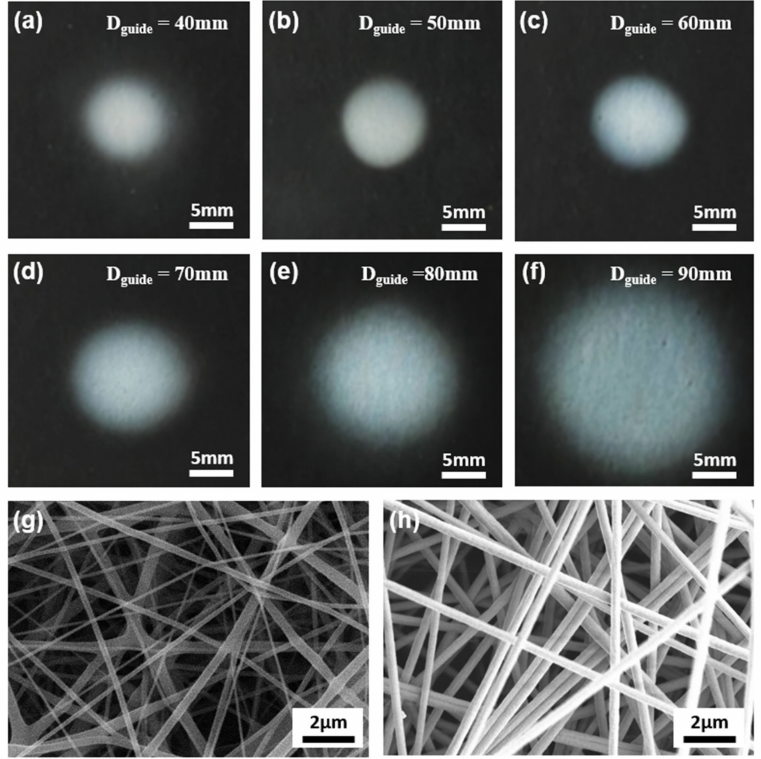
Figure 5. ( a – f ) Optical images of electrospun nanofiber mats of diameters ( a ) 90, ( b ) 80, ( c ) 70, ( d ) 60, ( e ) 50, and ( f ) 40 mm; ( g , h ) SEM images of PU nanofibers electrospun using cylindrical dielectric guides of diameters ( g ) 90 and ( h ) 40